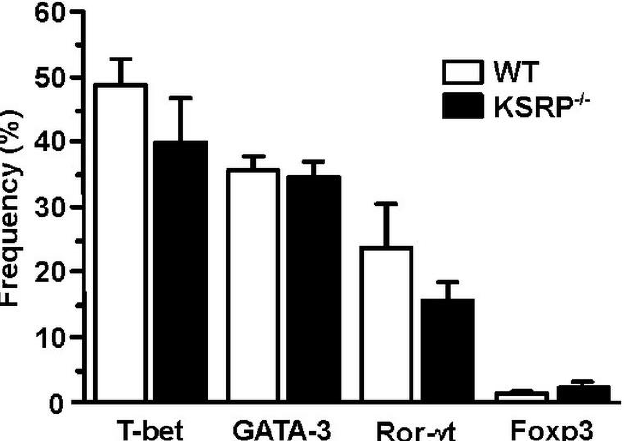
Figure 4. Expression of GATA-3 in stimulated CD4 + T cells is not affected by KSRP deficiency. Splenic CD4 + T cells (WT, KSRP − / − ) were isolated by magnetic bead separation, and were polyclonally stimulated with agonistic CD3- (1 µg/mL) and CD28- (2 µg/mL) specific antibodies for 72 h. Transcription factor expression was delineated by intracellular flow cytometric analysis. Data denote the frequencies of transcription factor-positive CD4 + T cell (mean + SEM, n = 4).